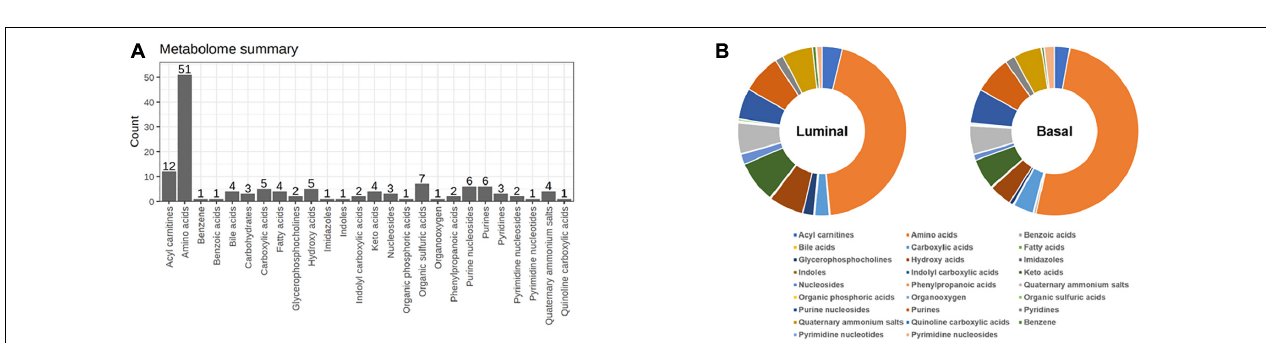
FIGURE 5 | Distinct metabolite profiles in basal and luminal MIBC subtypes. (A) The types and amounts of metabolites examined in this study. (B) Relative frequencies of metabolites in basal and luminal MIBC subtypes.